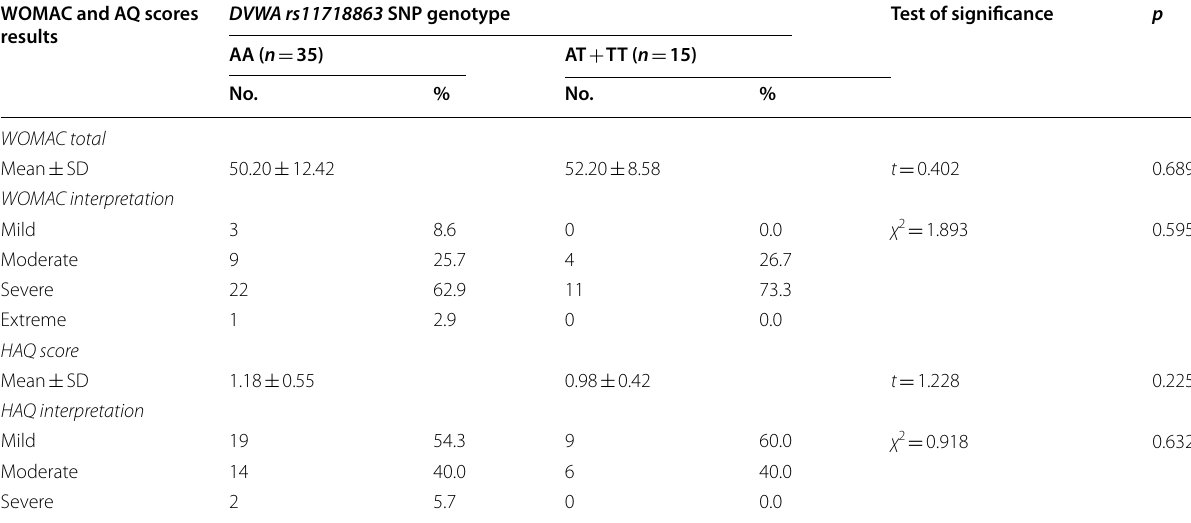
Table 5 Relation between DVWA rs11718863 single nucleotide polymorphism with WOMAC and HAQ scores results in patient group